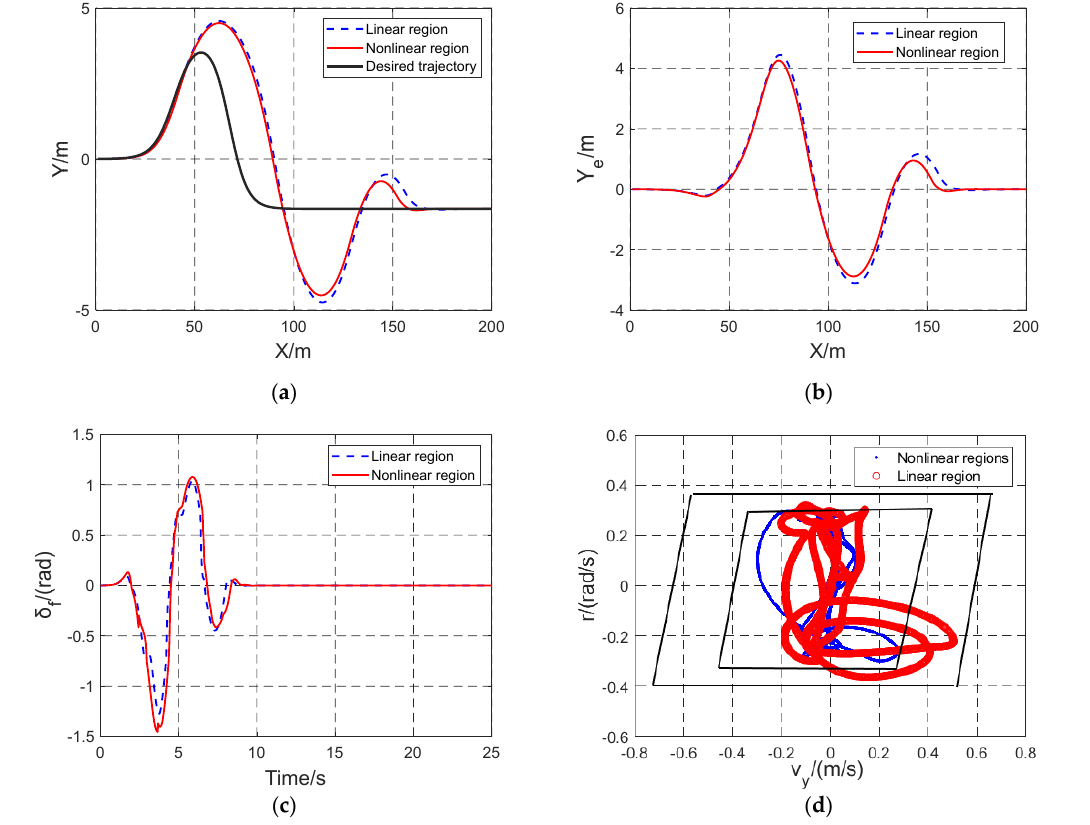
Figure 12. Simulation results of wet asphalt pavement trajectory tracking at 75 km · h − 1 ; ( a ) Trajectory tracking results; ( b ) Lateral tracking error; ( c ) The front-wheel steering angle; ( d ) Comparison of the lateral velocity and yaw rate under whether slip constraints are applied.